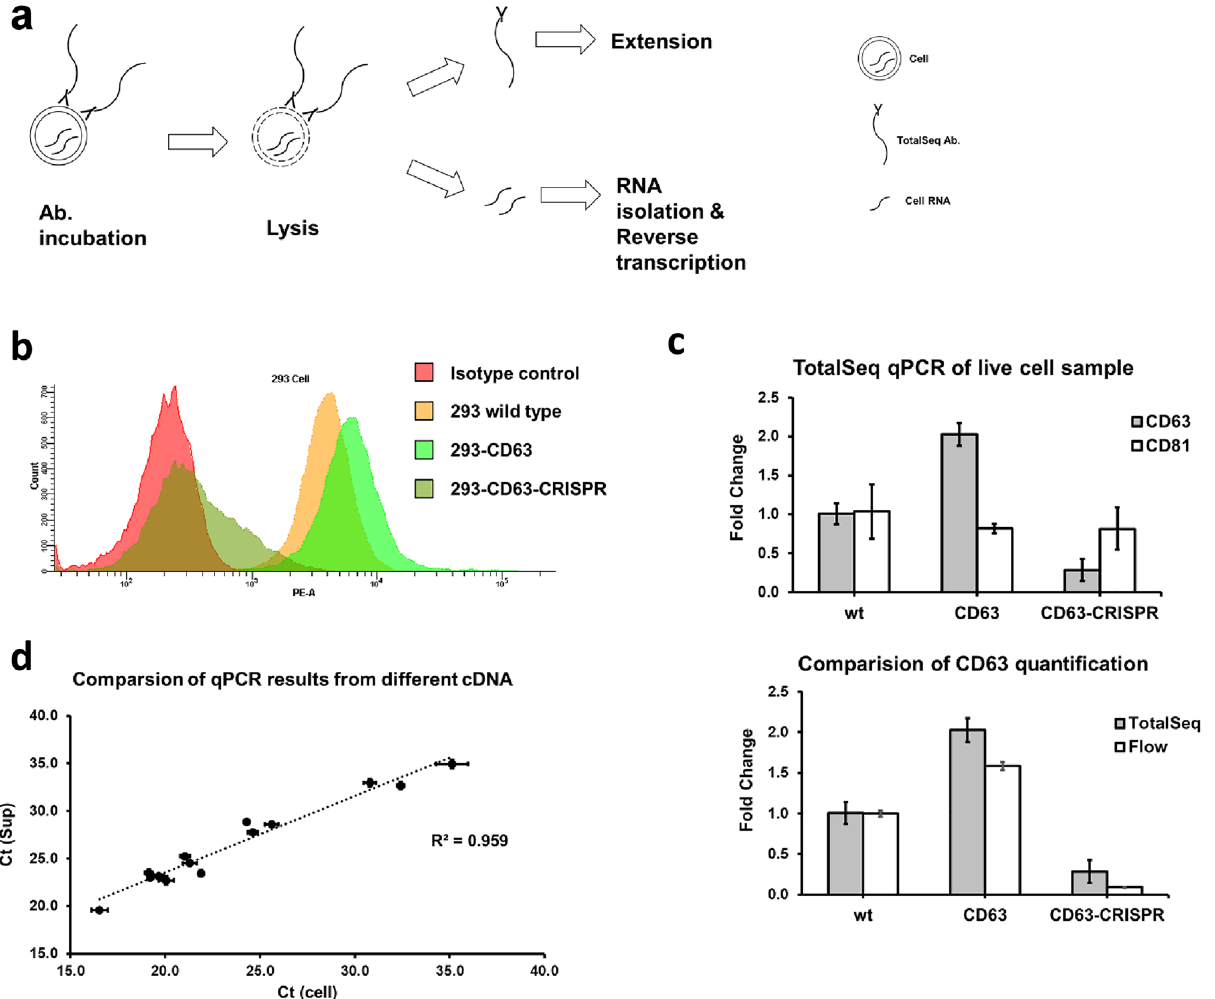
Figure 2. Cell surface protein were profiled with TotalSeq antibody. ( a ) Workflow for cell samples. ( b ) Overlaid histogram plot flow cytometry results of 293-WT, 293-CD63 and 293-CD63-CRISPR cell stain with either CD63-PE or isotype control-PE antibody. Representative result of three independent samples shown. ( c ) Result on the same cell sample as in ( b ) with TotalSeq qPCR method. Data were normalized to wild type sample. ( d ) Gene expression level was tested from RNA isolated by Trizol from cell (X axis) or cleared supernatant (Y axis). Samples were showed in